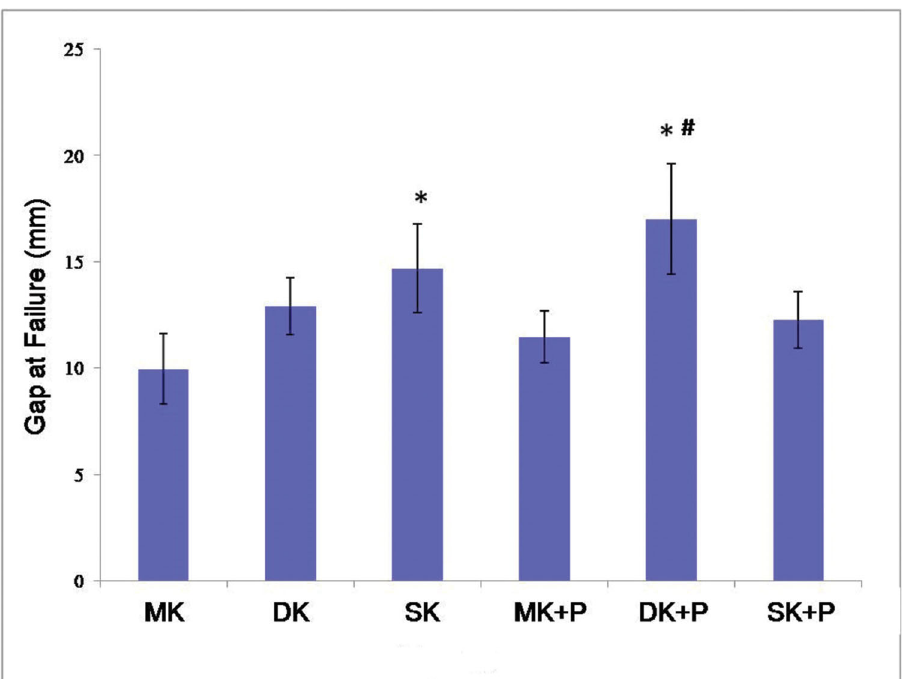
Figure 4 - The gap at failure of the six suture techniques. The lowest gap at failure was observed in the MK group (10.0 mm), while the largest was in the DK + P group. There were no statically significant differences between MK and DK, MK + P, and SK + P ( p 4 0.05). However, SK and DK + P improved the gap at failure significantly. As compared to DK combined with epitendinous suture, there was a smaller gap at failure in the MK + P and SK + P groups. * p o 0.05 versus MK # p o 0.05 versus MK + P group. MK, modified Kessler suture without epitendinous suture; DK, double knot Kessler-loop lock flexor tendon suture without epitendinous suture; SK, single knot Kessler-loop lock flexor tendon suture without epitendinous suture; MK + P, modified Kessler suture with epitendinous suture; DK + P, double knot Kessler-loop lock flexor tendon suture with epitendinous suture; SK + P, single knot Kessler-loop lock flexor tendon suture with epitendinous